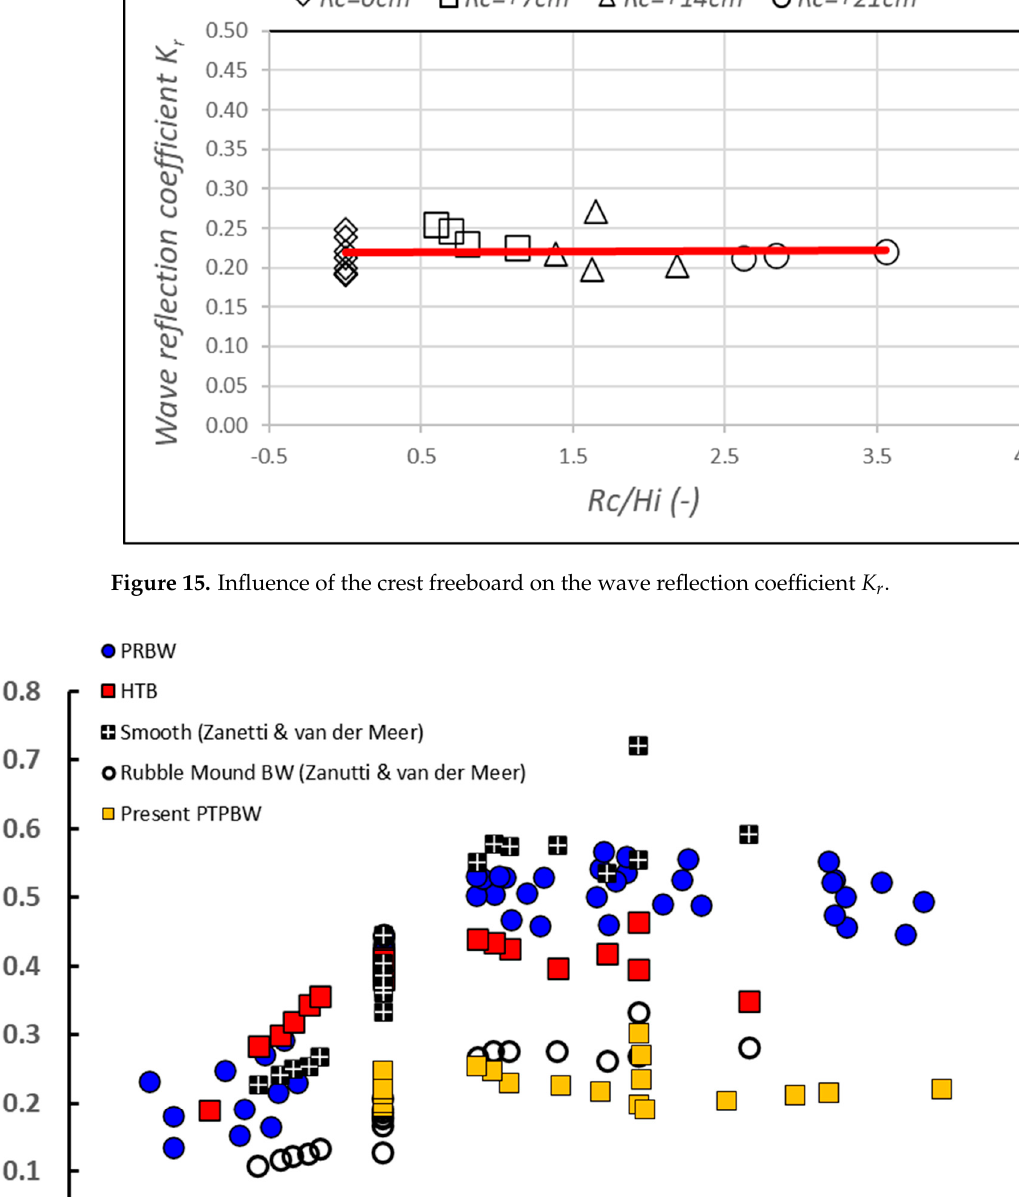
( d ) Figure 14. Variance spectrum of the reflected wave in different water depths. ( a ) TH6-d26H10T15, Depth d = 26 cm, Variance density spectrum; ( b ) TH6-d33H10T15, Depth d = 33 cm, Variance den- sity spectrum; ( c ) TH6-d40H10T15, Depth d = 40 cm, Variance density spectrum; ( d ) TH6- d47H10T15, Depth d = 47 cm, Variance density spectrum.